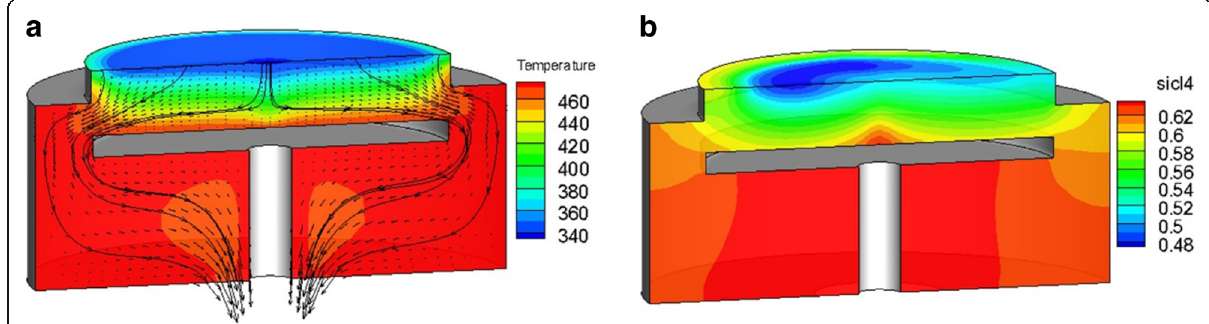
Fig. 5 Contours of plasma parameters inside the reactor. a Temperature distribution and particle path lines r. b Mass fraction contours of product SiCl